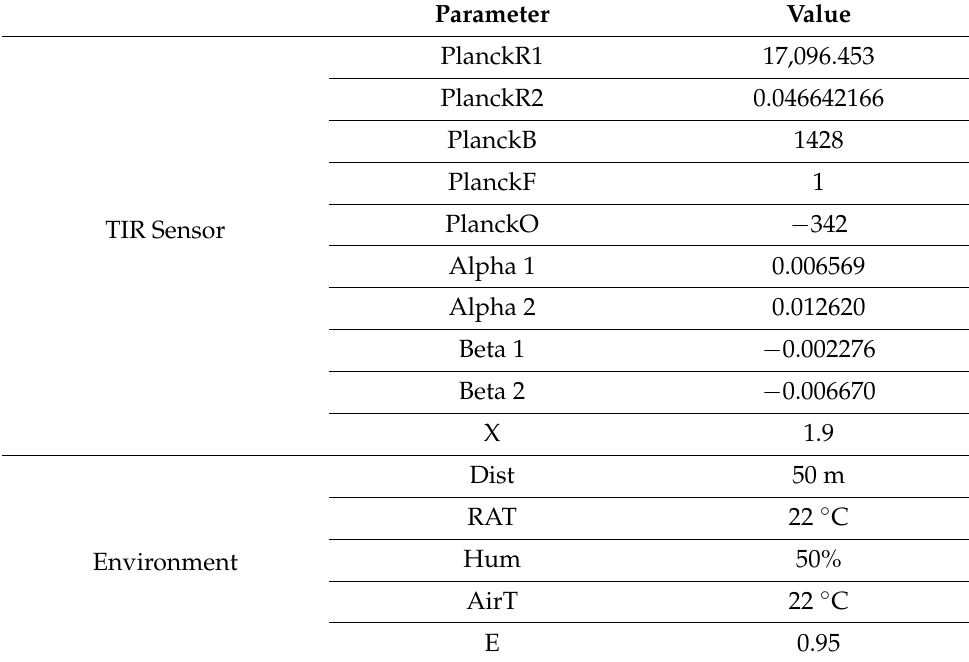
Table 2. Each parameter included in Equations (1)–(6).